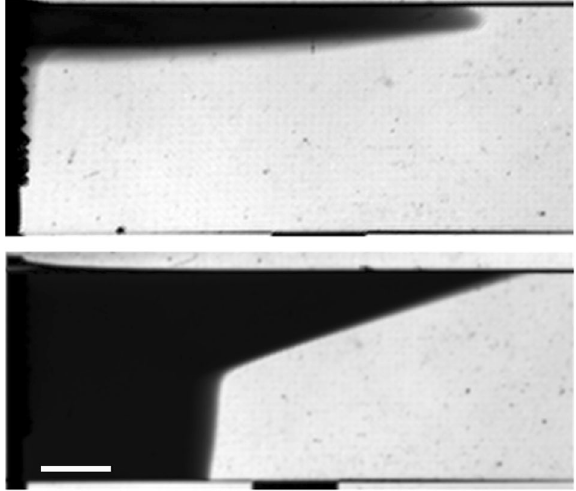
Fig. 5 Marangoni- fl ow-driven chemical fronts. The front propa- gates from left to right in the presence of buoyancy (top) and in the absence of gravity (bottom). Scale bar: 5.0